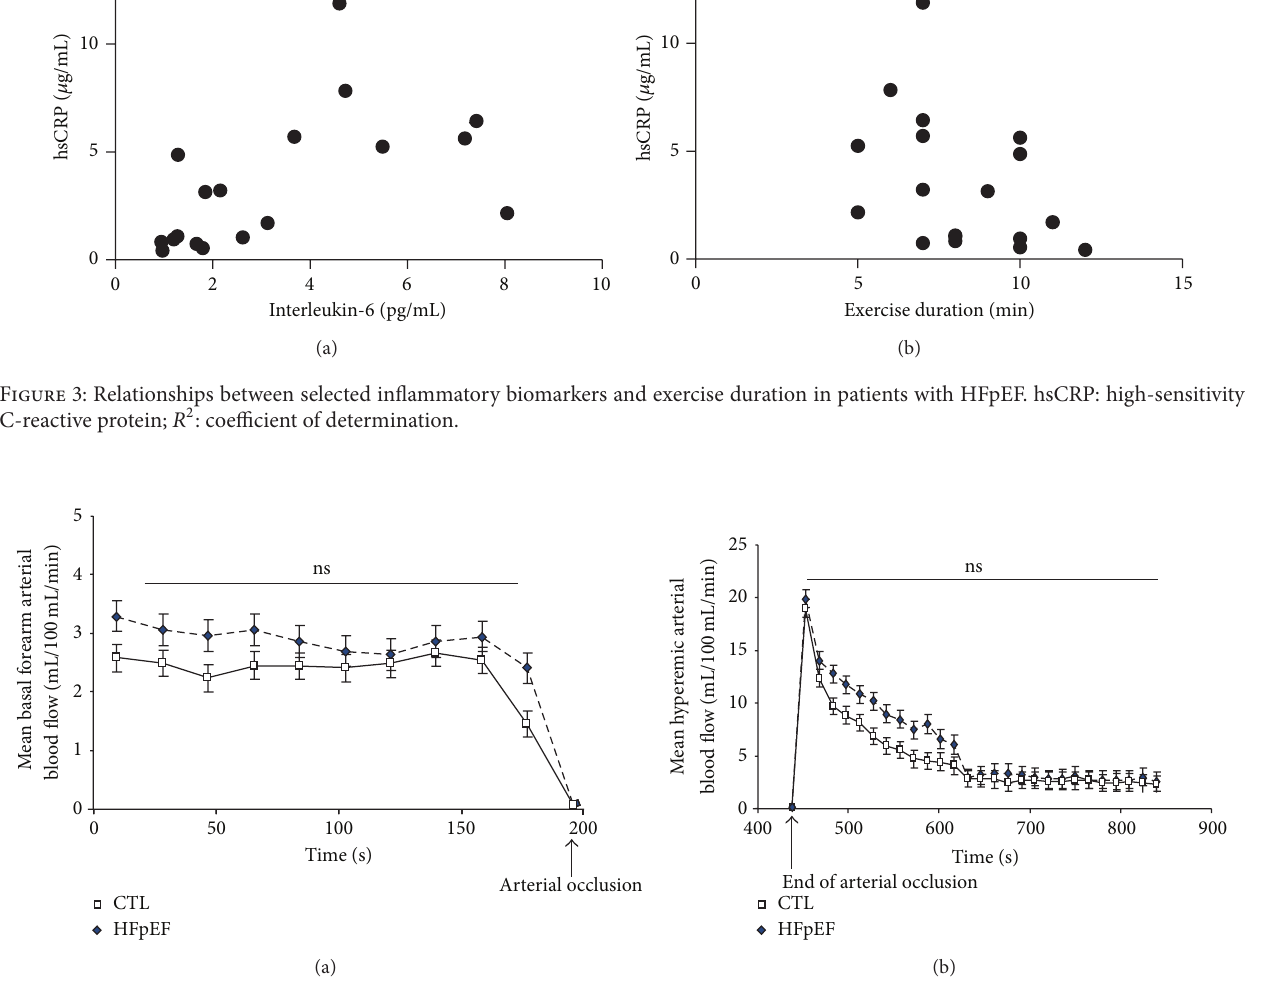
Figure 4: Changes in basal (a) and hyperemic (b) arterial blood flow for patients with HFpEF versus healthy control subjects. Values are expressed as adjusted mean ± standard